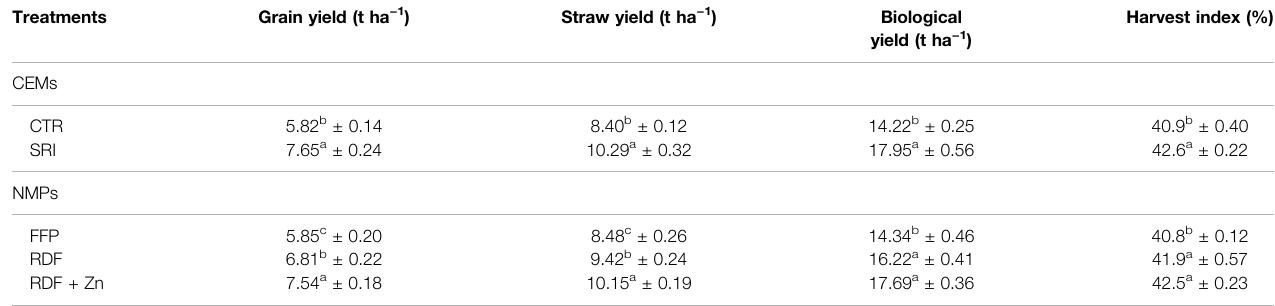
TABLE 4 | Effect of different CEMs and NMPs on the grain, straw, and biological yield and harvest index of rice (4 years av.). Treatments